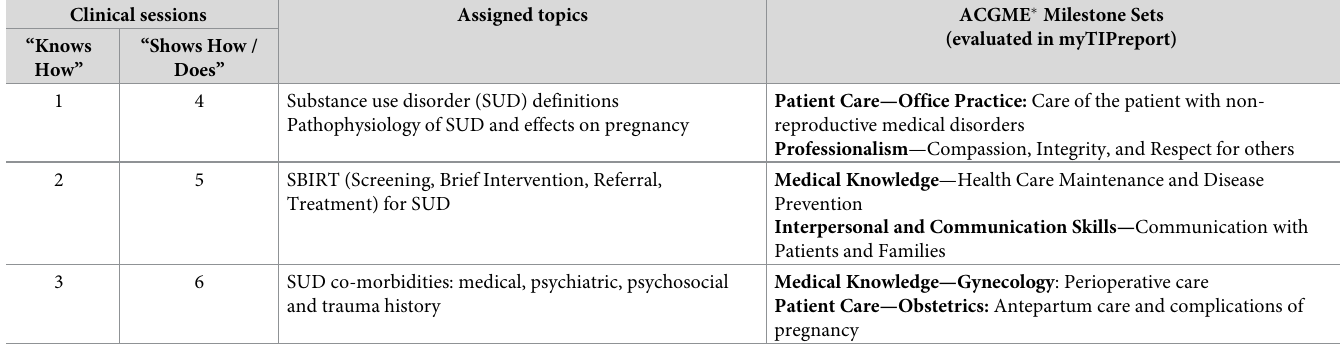
Table 1. Format of pilot curriculum on substance use disorders for OBGYN residents. Clinical